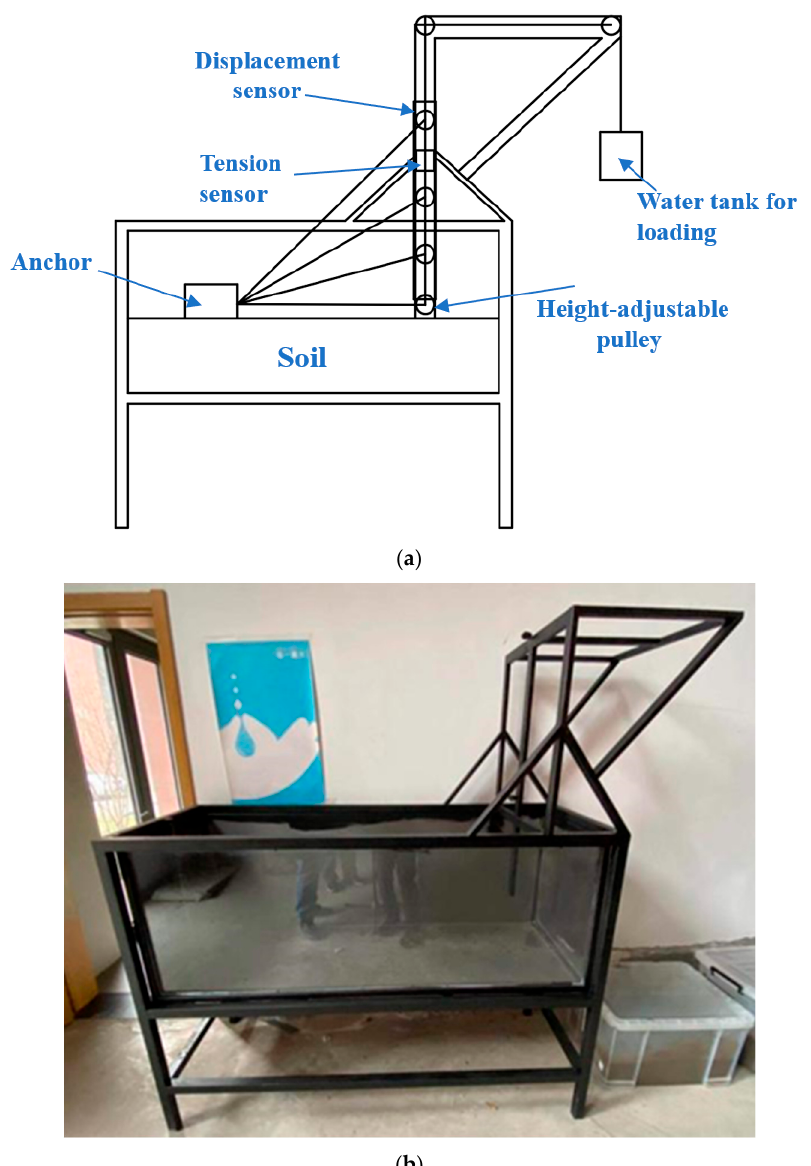
Figure 4. The model test tank.(a) A schematic map of the test tank; and (b) A physical map of the test tank.